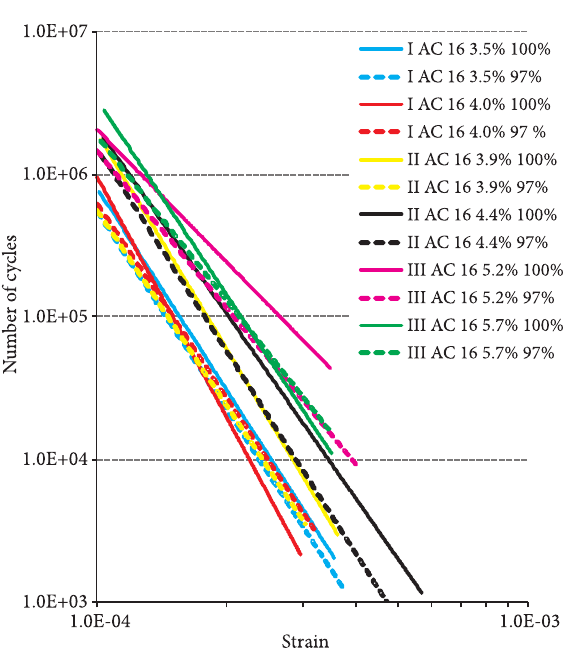
Fig. 6. Wöhler diagrams comparison of the individual AC 16